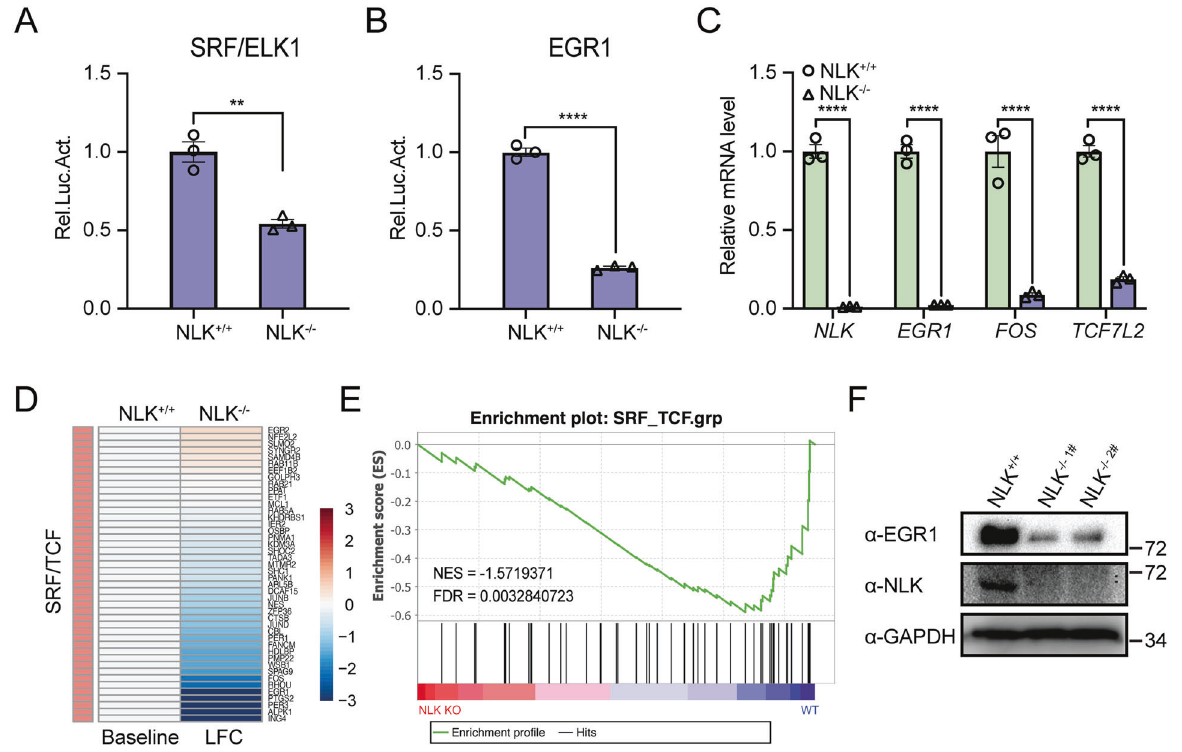
Fig. 2 Loss of NLK blocks SRF/ELK signaling. A , B Luciferase assays for SRF/ELK reporter ( A ) or EGR1 reporter ( B ) in wild-type and NLK- de fi cient HCT116 cells. SRF/ELK reporter (200 ng) or EGR1 reporter (200 ng) was transfected into NLK-de fi cient HCT116 cells for 36 h, followed by analysis with a luciferase kit assay ( n = 3). C Real-time PCR showing the gene transcription levels of NLK, EGR1, FOS, and TCF7L2 in wild-type and NLK-de fi cient HCT116 cells. The real-time PCR values were normalized to the GAPDH values ( n = 3). D Heatmap showing the differentially expressed genes related to SRF/TCF signaling between wild-type and NLK-de fi cient HCT116 cells. E GSEA showing SRF/TCF signaling enrichment between wild-type cells and NLK-de fi cient HCT116 cells. F Immunoblotting showing the protein levels of EGR1 and NLK in NLK- de fi cient HCT116 cells using the indicated antibodies. GAPDH was used as a loading control. Data are representative of three independent experiments and presented as the mean ± SEM. Statistical signi fi cance was analyzed by Student ’ s t -test or ANOVA (** p < 0.01, **** p < 0.0001). LFC log fold change, NES normalized enrichment score, FDR false discovery rate. Source data ( A – F ) are provided as a source data fi